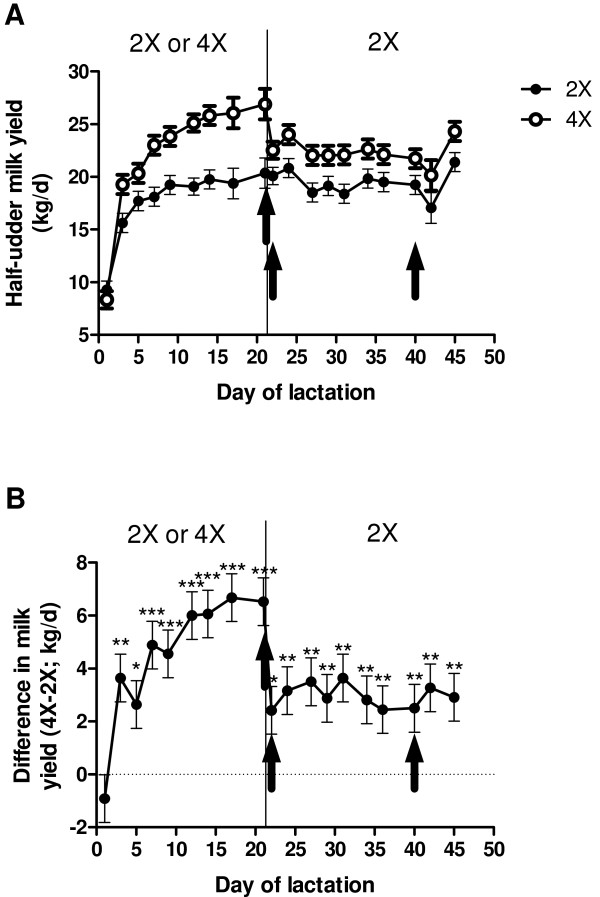
Changes in milk production in response to IMF.A. Total milk yield or B. difference in milk yield between udder halves, of 6 cows assigned to unilateral frequent milking (UFM; twice daily milking (2×) of the left udder half, four times daily milking (4×) of the right udder half) for days 1 to 21 of lactation. Quartermilk production was measured through 45 d of lactation, and milk production from the 2× udder half was subtracted from that of the 4× udder half to obtain differential yield. There was no difference between udder halves in milk production on day 1 of lactation (P > 0.30). Milk production of the 4× udder half increased dramatically (P < 0.001) during UFM and was greater than that of the 2× udder half through day 45 of lactation (P < 0.01). Black vertical arrows indicate timing of biopsy sampling.